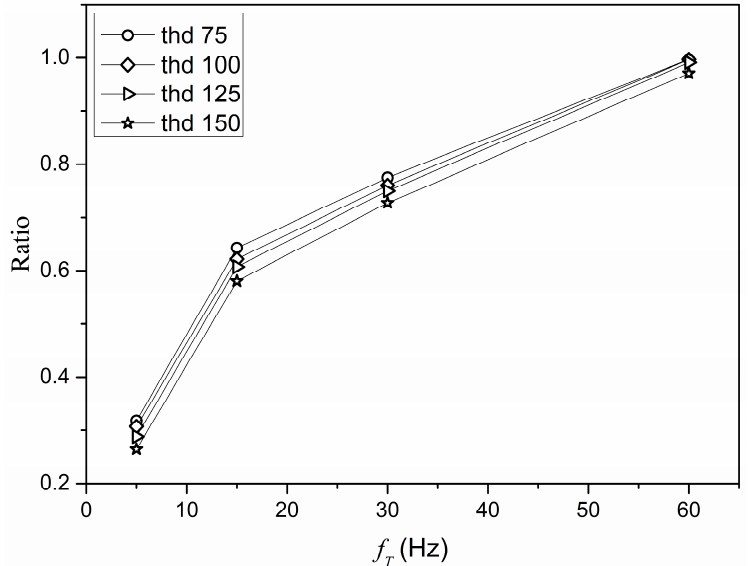
Figure 10. Graph of the proportion of white in the images depending on the frequency f T .